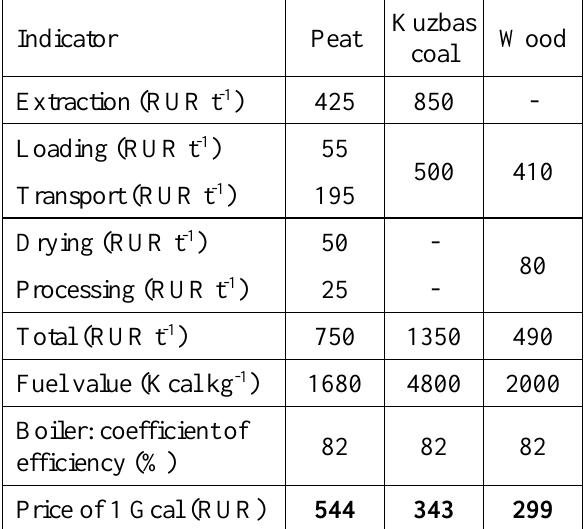
Table 5. Comparison of the efficiencies of different energy resources in the production of thermal energy (Bernatonis et al.